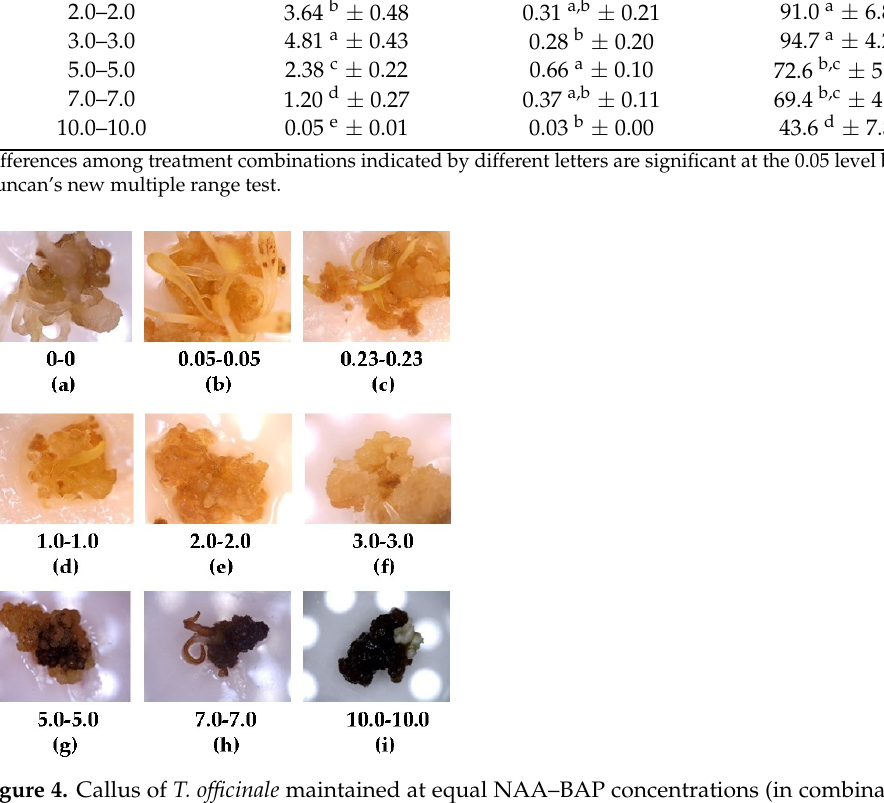
Figure 4. Callus of T. officinale maintained at equal NAA–BAP concentrations (in combination) in the eighth week of culture. ( a ) 0–0; ( b ) 0.05–0.05; ( c ) 0.23–0.23; ( d ) 1.0–1.0; ( e ) 2.0–2.0; ( f ) 3.0–3,0; ( g